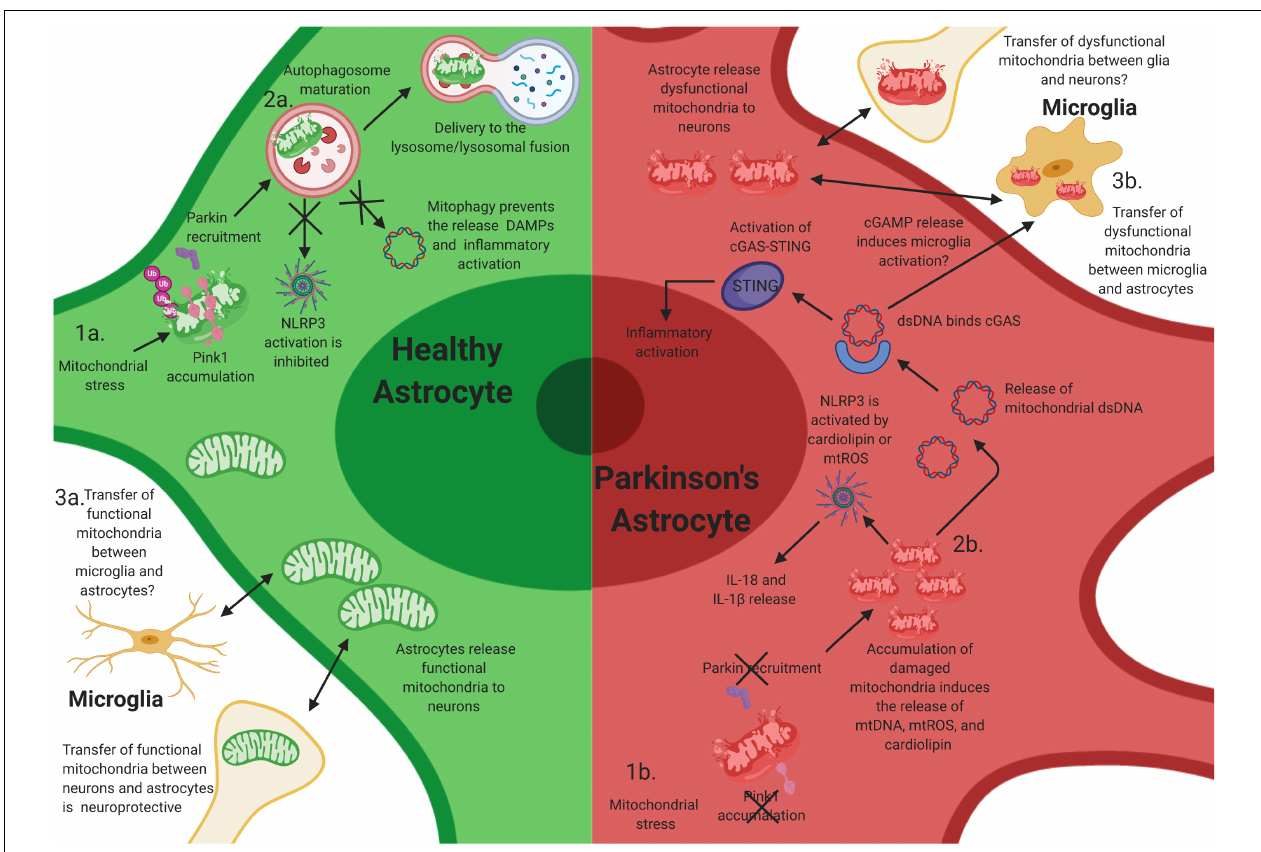
FIGURE 2 | Mitochondrial dysfunction in astrocytes contributes to neuroinflammatory activation of astrocytes. Mutations in PINK1 and Parkin likely elicit neuroinflammatory activation in astrocytes. (1a) After mitochondrial stress, PINK1 protein accumulates on the outer mitochondrial membrane. Phosphorylation of polyubiquitin and Parkin induces autophagosome maturation and eventually delivery to the lysosome. (1b) Loss-of-function (LOF) mutations in PINK1 and Parkin prevent PINK1 accumulation on the mitochondrial membrane and the activation of Parkin during mitochondrial stress, resulting in the accumulation of damaged mitochondria within astrocytes. This likely facilitates chronic inflammatory activation through multiple inflammatory pathways, including NLRP3 activation. (2a) Functional mitophagy prevents the release of damage-associated molecular patterns (DAMPs)/pathogen-associated molecular patterns (PAMPs) and activation of the NLR family, pyrin domain containing 3 (NLRP3) inflammasome in astrocytes. (2b) The accumulation of damaged mitochondria likely results in the release of intracellular DAMPs/PAMPs, cardiolipin, and mtROS, which activates NLRP3 and the cyclic guanosine monophosphate–adenosine monophosphate cGAMP synthase (cGAS)/stimulator of interferon genes (STING) pathway, resulting in inflammatory activation and release of interleukin (IL)-1 β and IL-18, and potentially inducing the activation of microglia via extracellular release of cGAMP. (3a) Transfer of functional mitochondria from astrocytes to neurons is thought to be neuroprotective; however, whether microglia release functional mitochondria to astrocytes is elusive. (3b) Joshi et al. have shown that activated microglia can release dysfunctional and fragmented mitochondria to astrocytes. Astrocytes then transfer dysfunctional mitochondria to neurons, resulting in neuronal death. However, whether this occurs in vivo is